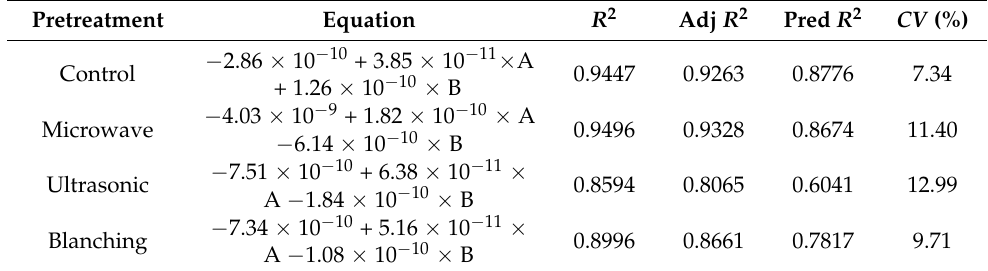
Table 3. Response surface method (RSM) modeling for predicting effective moisture diffusivity coefficient ( D eff ) under a hybrid convective-infrared (HCIR) dryer with various pretreatments.